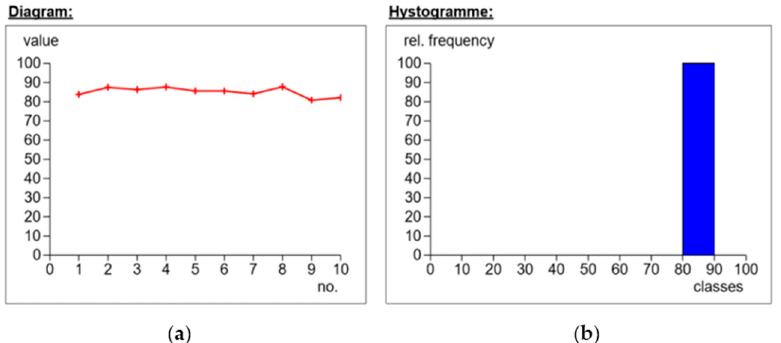
Figure 10. Application of IMS65 CTLX fabric, biaxial fabric, weave 0/+45 ◦ , MGS L285/H285 warp: ( a ) dependence of hardness on the number of measurements; ( b ) percentages of hardness.